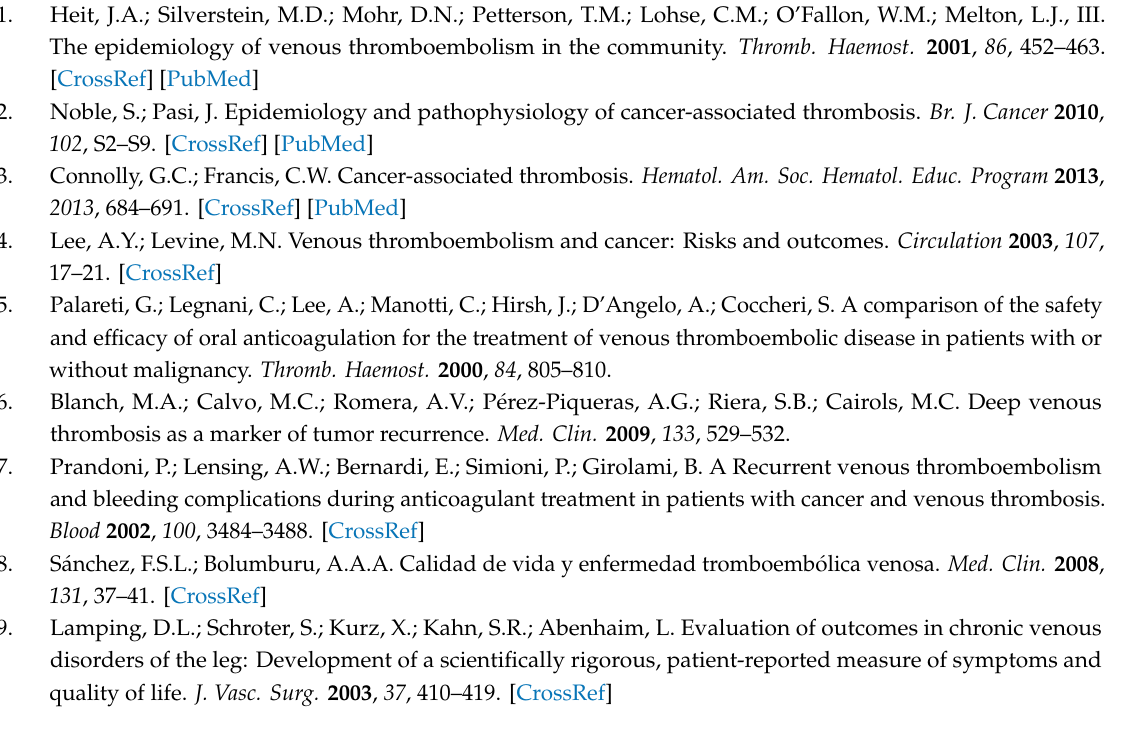
Table S1: recruitment per center; Table S2: marital status, education status, employment status, and gross income of the study patients; Table S3: di ff erences in terms of QLQ-c30 functional and symptom scales scores between patients with pulmonary embolism and deep vein thrombosis; Table S4: sex-related di ff erences in terms of EORTC QLQ-c30, EQ-5D-3L, PEmb-QoL and Veines-QoL / Sym questionnaire results in patients with venous thromboembolic disease; Table S5: di ff erences in the EORTC QLQ-C30 functional scales in patients with venous thromboembolic disease according to tumor site; Table S6: di ff erences in the EORTC QLQ-C30 symptoms scales in patients with venous thromboembolic disease according to tumor site; Table S7: di ff erences in the EQ-5D-3L results in patients with venous thromboembolic disease according to tumor site; Table S8: di ff erences in the VEINES-QOL / Sym results in patients with venous thromboembolic disease according to tumor site; Table S9: di ff erences in the PEmb-QoL score results in patients with venous thromboembolic disease according to tumor